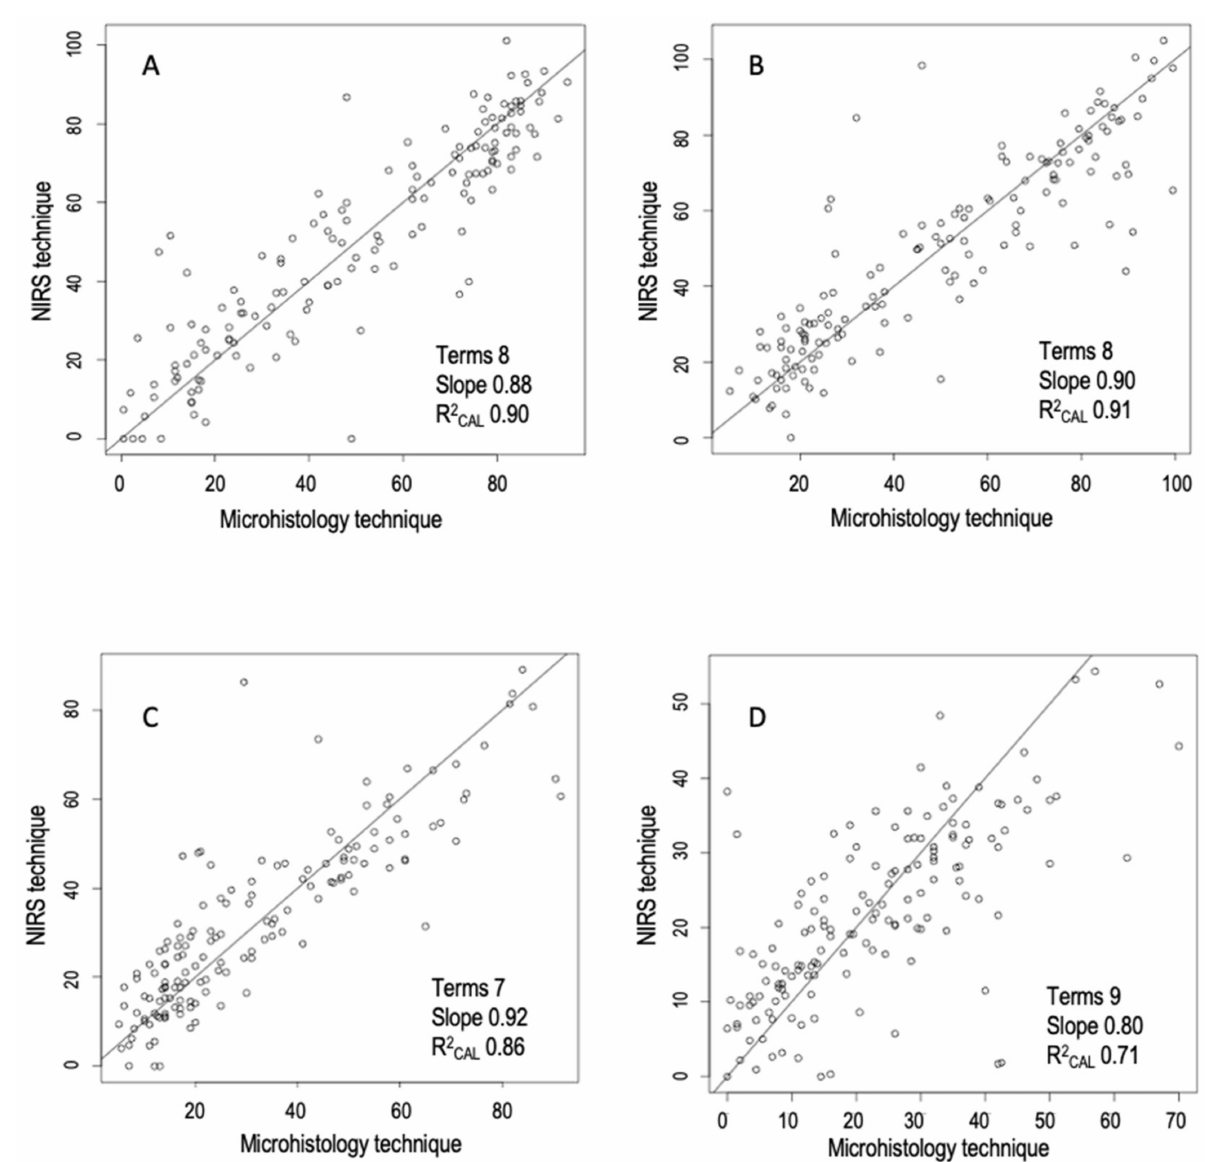
Figure 3. Linear regression between fecal cuticle microhistological analysis and near infrared reflectance spectroscopy predictions for four functional groups of plants: woody ( A ), herbaceous ( B ), graminoids ( C ) and Fabaceae ( D ) found in 150 fecal samples of Pyrenean chamois. The numbers of terms, the slope and the coefficient of determination for calibration (R 2 CAL ) are also